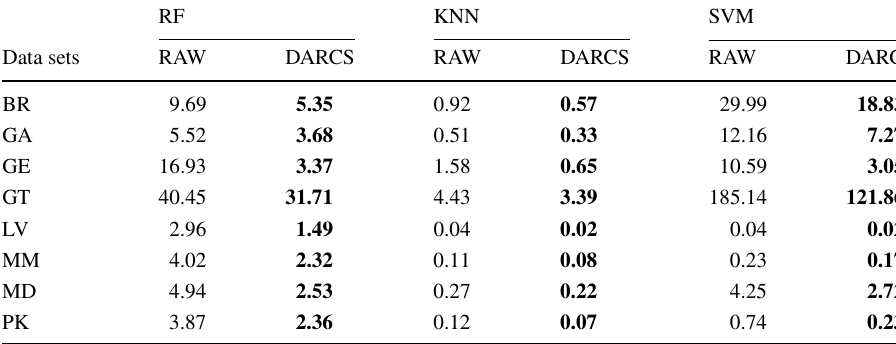
Table 7 Reduction rate comparison